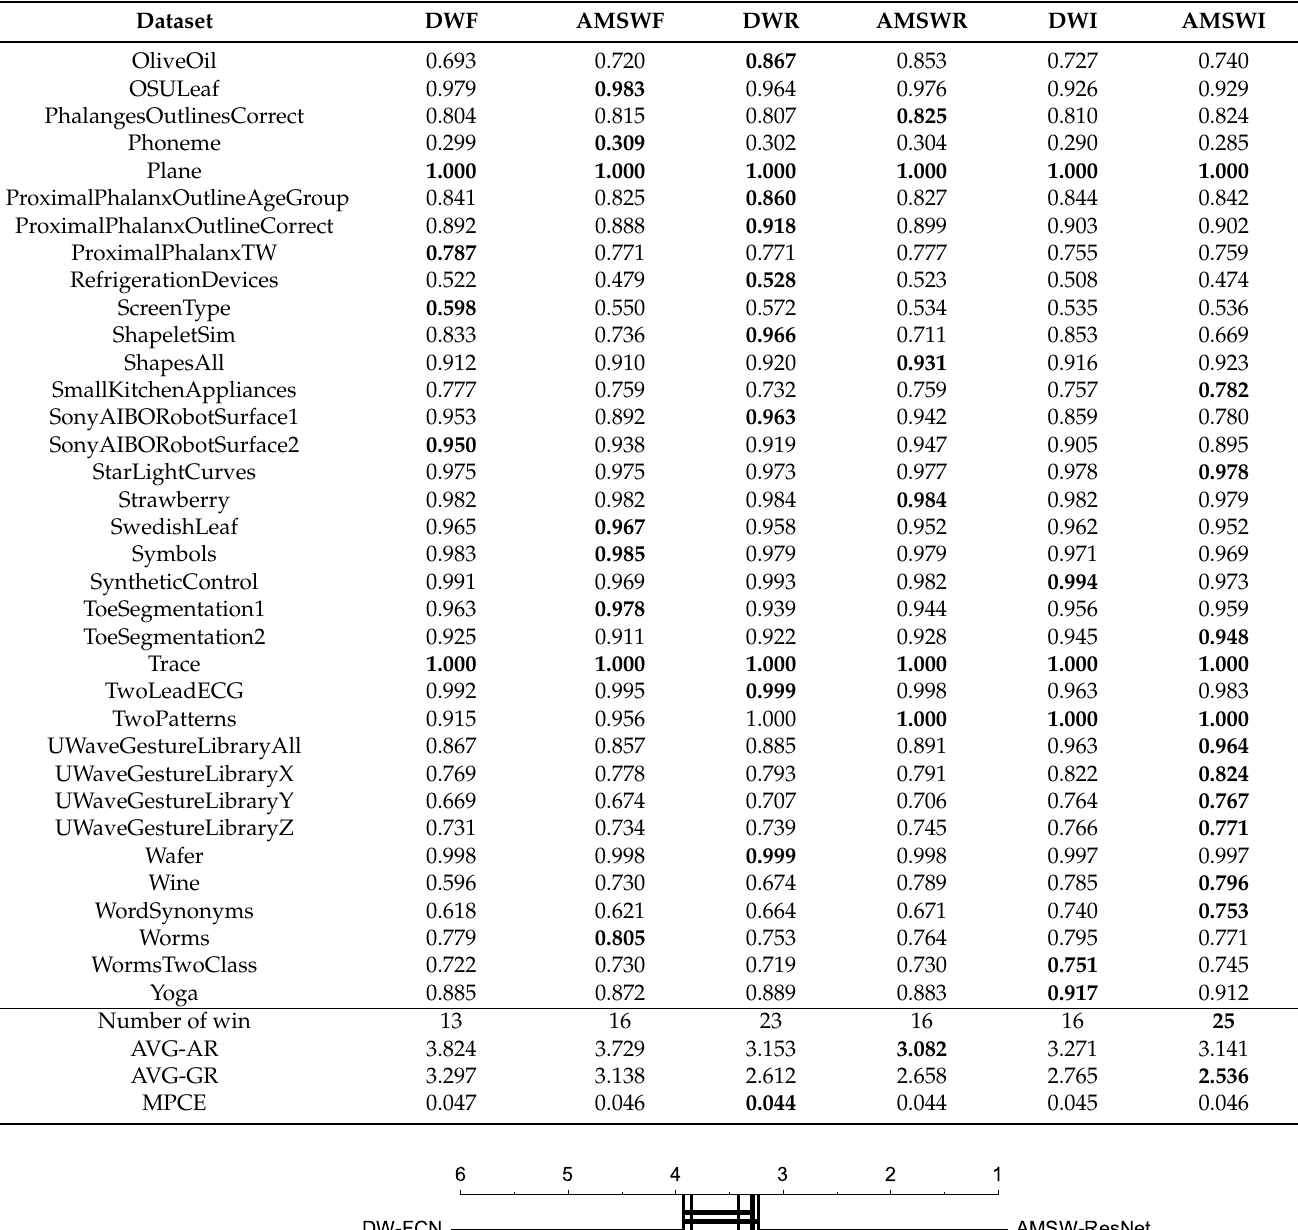
Figure 6. Critical difference diagram showing statisitical difference comparison of DW-FCN, DW- ResNet, DW-Inception, AMSW-FCN, AMSW-ResNet, and AMSW-Inception on the UCR